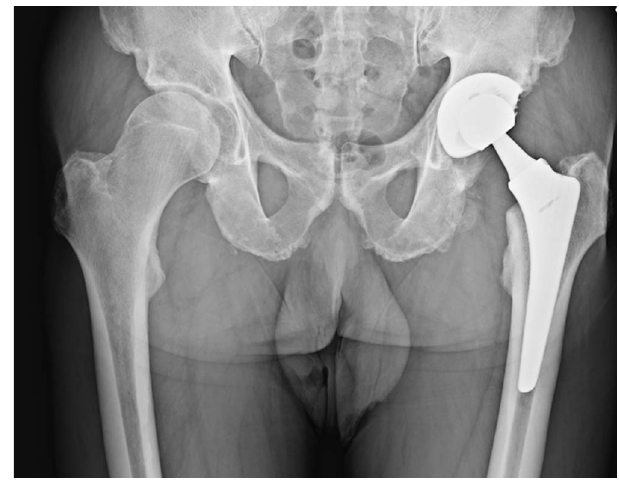
Figure 1. Anteroposterior pelvis X-ray showing CLS Brevius Kinectiv Stem 5 years after surgery with no signs of mobilization or